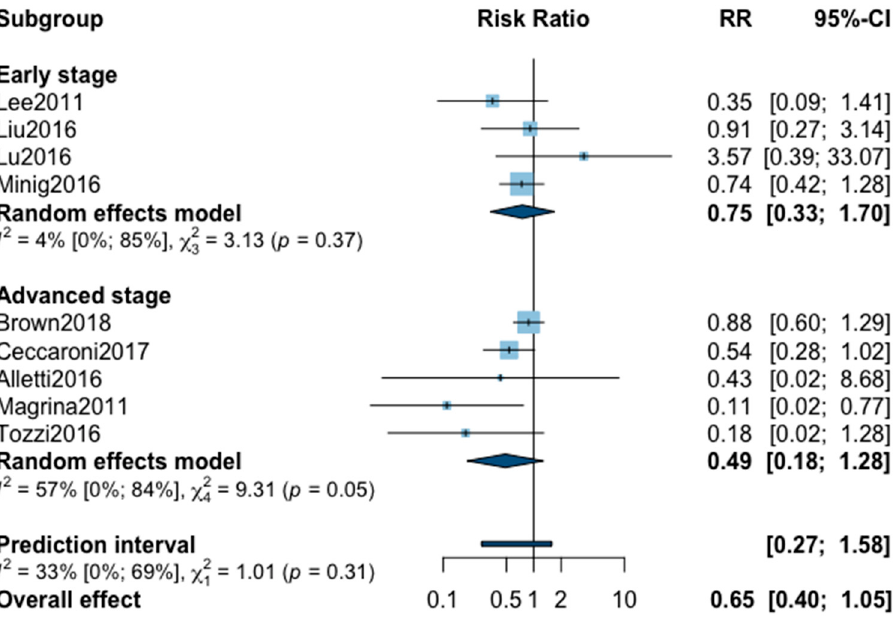
Figure A7. Meta ‐ analysis for postoperative complications all grade .